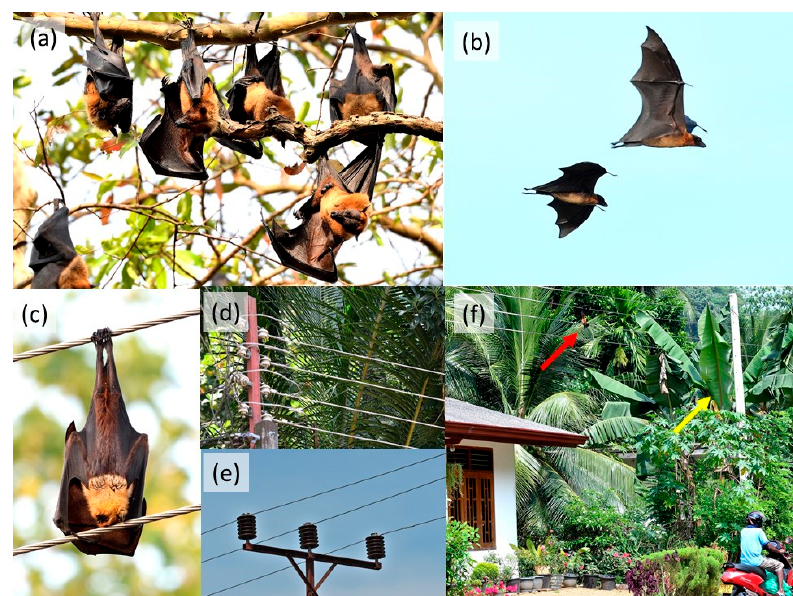
Figure 1. Indian flying foxes gather in diurnal colonies ( a ) and leave them at sunset ( b ) to forage on fruit trees. They were frequently found electrocuted when perching on wires ( c ) of two different types of distribution power lines ( d , e ), always in urbanized areas (red arrow) and very close to cultivated fruiting trees (yellow arrow) ( f ). Pictures: J.L. Tella.